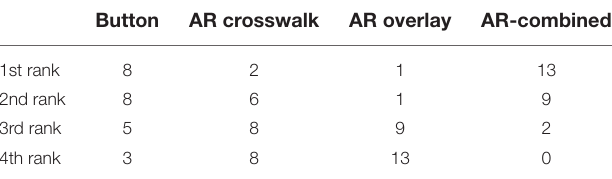
TABLE 1 | Ranking results by frequency of nomination.